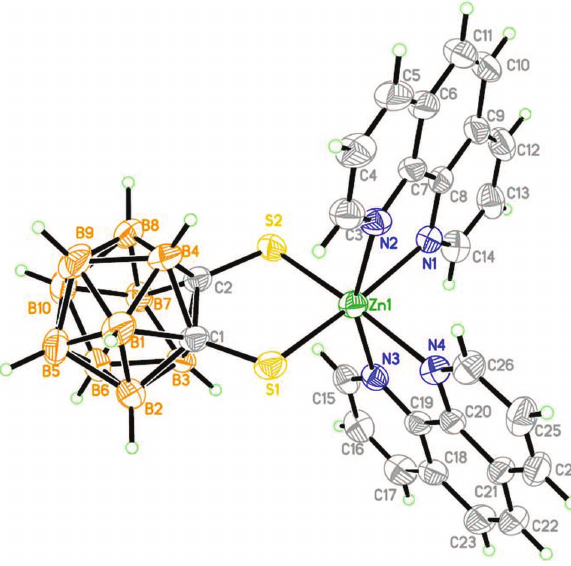
Table 1: Data collection and